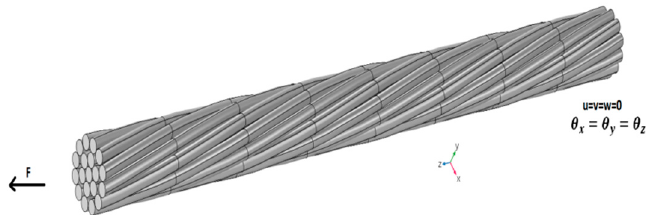
Figure 3. Multilayer conductor (1 + 6 + 12).